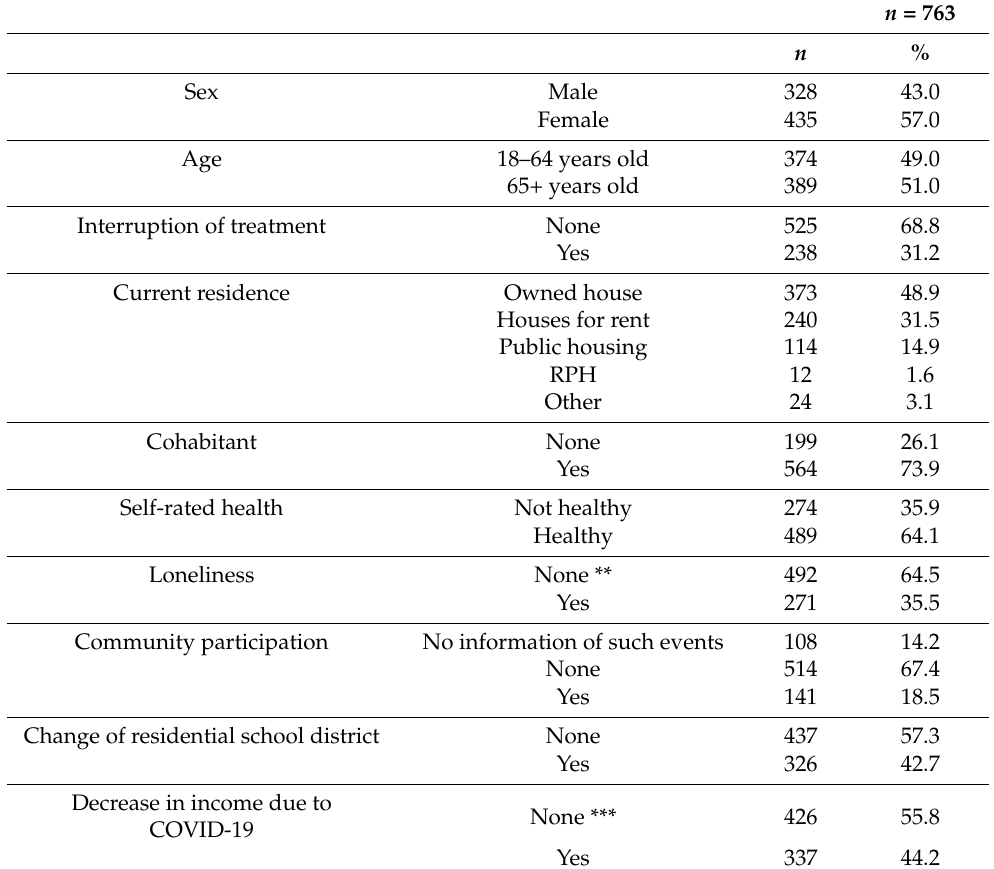
Table 1. The demographic characteristics of the analysed